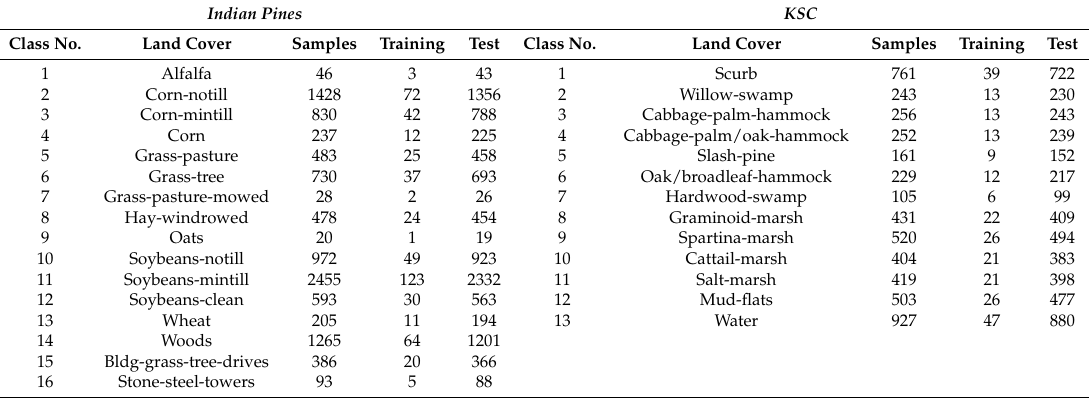
Table 1. Number of total, training, and test samples, with a partition factor τ = 0.05 of each land-cover class for the Indian Pines and Kennedy Space Center (KSC) datasets. Indian Pines KSC Class No. Land Cover Samples Training Test Class No. Land Cover Samples Training